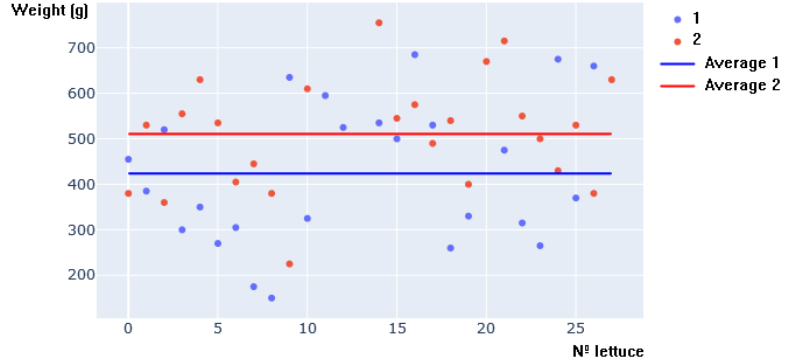
Figure 15. Mass of lettuces after harvesting (1: PV glasses, 2: conventional glasses).